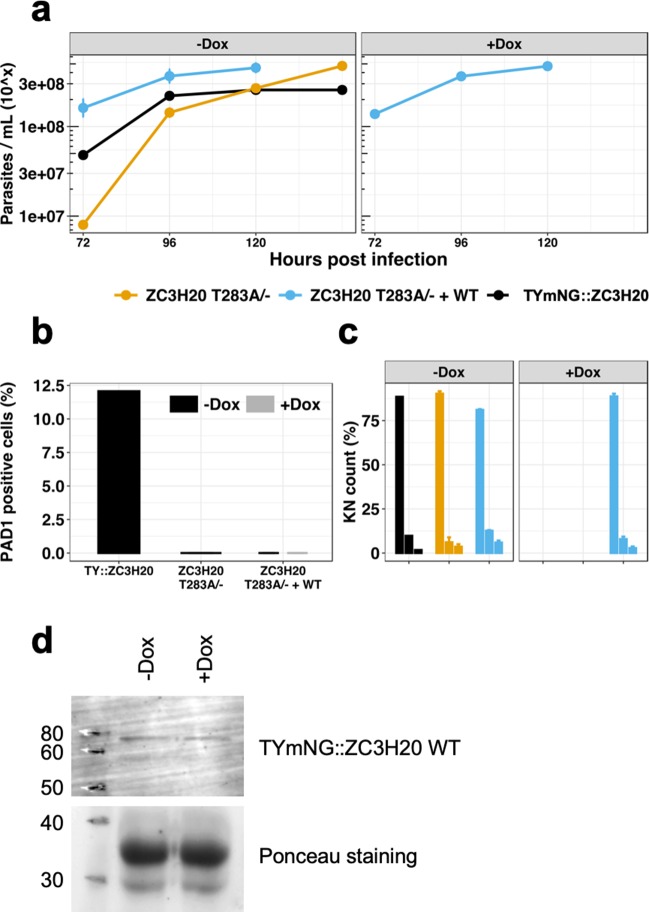
Add-back inducible ectopic expression of a WT copy of TbZC3H20 in the TbZC3H20T283A/- strain is leaky and does not rescue the WT phenotype.TbZC3H20T283A/- clones 1 (yellow), TbZC3H20T283A/- + WT add-back cell line (blue, + or - doxycyclin) and TYmNG::ZC3H20 control cell line (black). (a) Parasitaemia, n = 3, error bars = SEM; (b) Percentage of PAD1 positive cells at 120 hr post infection, n = 3, error bars = SEM, cells counted >100 per samples; (c) Percentage of KN count at 120 hr post infection, n = 3 error bars = SEM, cells counted >100 per samples, left bar: 1K1N, middle bar: 2K1N, right bar: 2K2N; (d) Western blot of in vitro culture of the TbZC3H20T283A/- + WT add-back cell line incubated in presence or not with doxycycline for 48 hr. The ectopic expression of the WT copy is revealed using the anti-TY tag antibody.